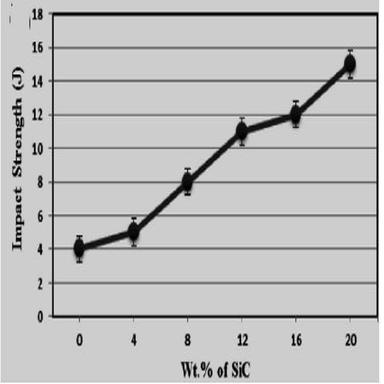
Variation of impact strength with % wt of SiC .